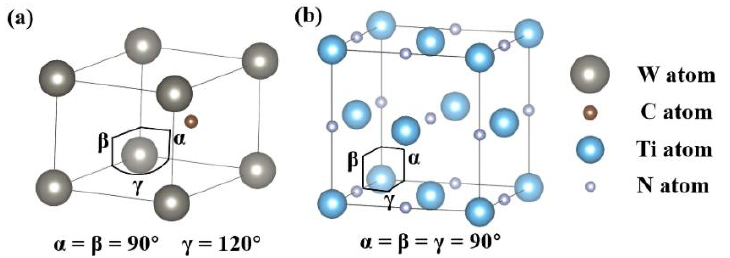
Figure 1. Crystal structures of ( a ) WC and ( b ) TiN (the colors of different atoms apply to the other models below).